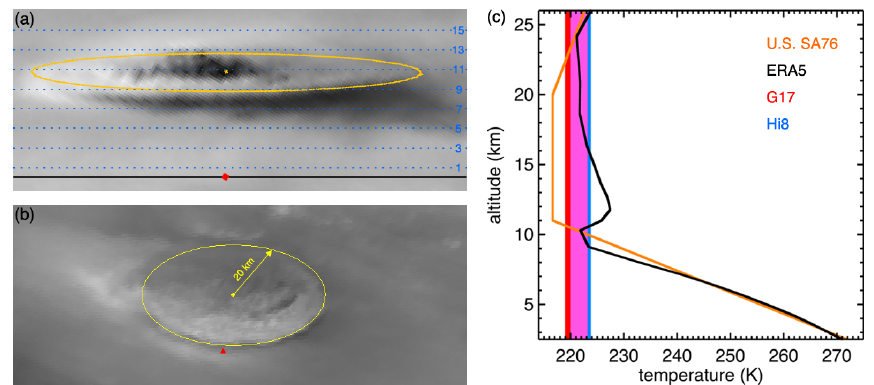
Figure 7. (a) GOES-17 band 2 fixed grid image (8 × magnification) and (b) Himawari-8 band 3 CEReS V20190123 image of the 29 Au- gust 2019 eruption of Sheveluch at 03:10UTC. The red diamond/triangle marks the volcano base, and the solid yellow line is a circle of 20km radius fitted to the umbrella cloud. In panel (a) , the baseline (solid black) and the odd number isoheights (in km, dotted blue) are also drawn. Panel (c) shows the ERA5 temperature profile (black line), the U.S. Standard Atmosphere 1976 temperature profile (orange line), and the range of the GOES-17 and Himawari-8 minimum BT 11 between 02:00–04:00UTC (red and blue shaded areas, overlap in